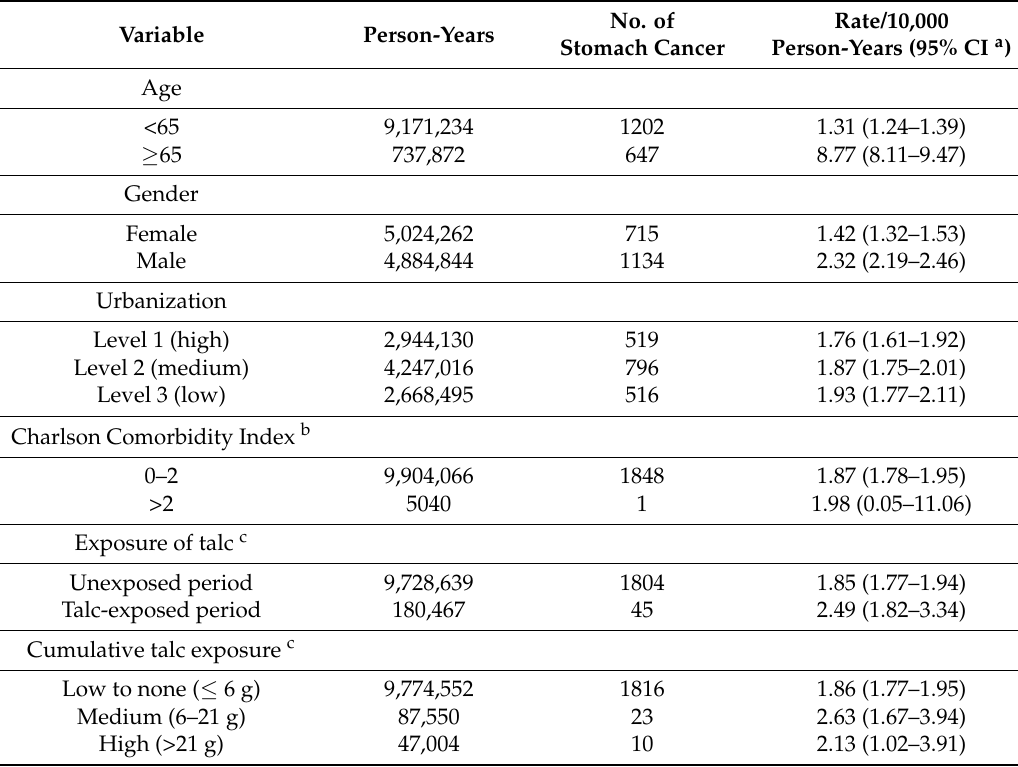
Table 2. Numbers of stomach cancer over time by